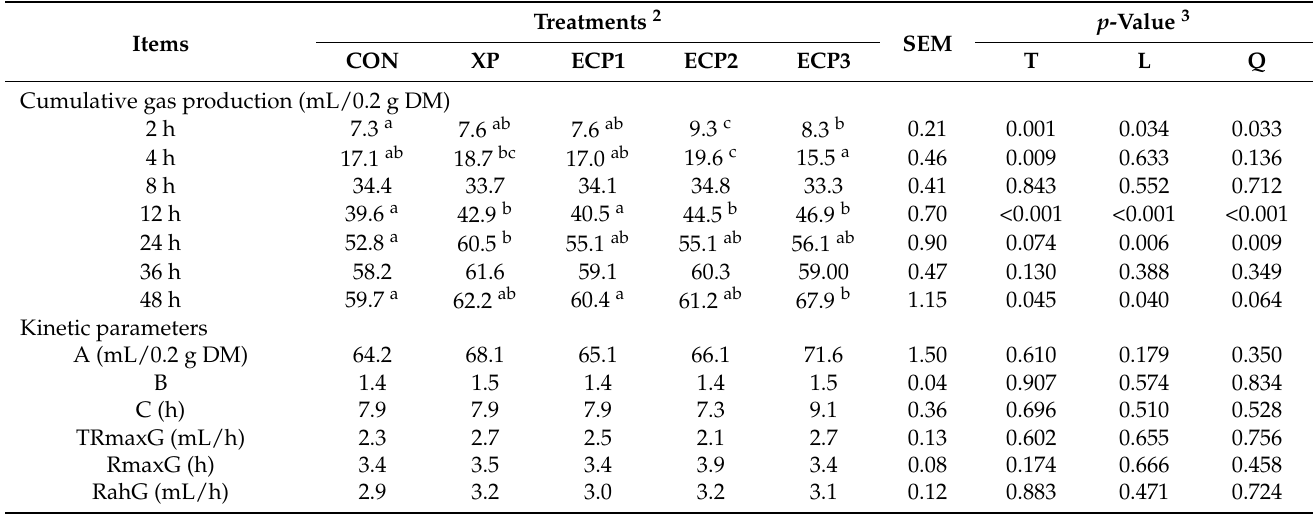
Table 2. In vitro kinetic parameters under different levels of ECP supplementation 1